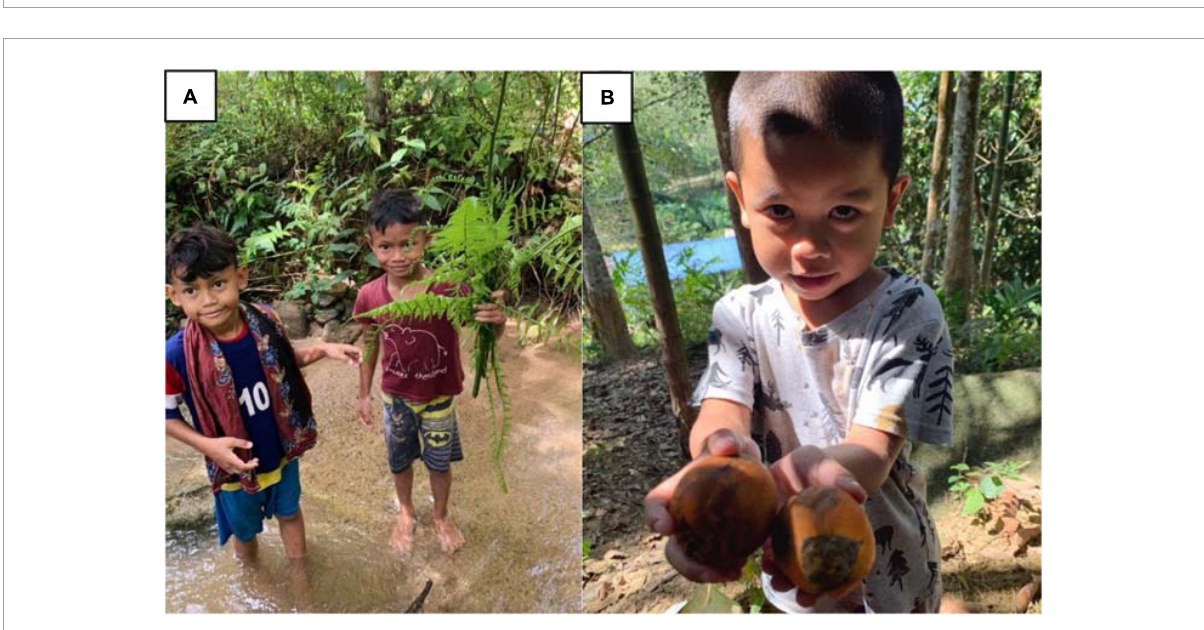
FIGURE3 The children of Tanjung Rambai collecting pucuk paku (A) and buah pinang (B) for their parents. Source: Photographed by the first author in Hulu Langat, Selangor, Malaysia, on 11 and 16 November